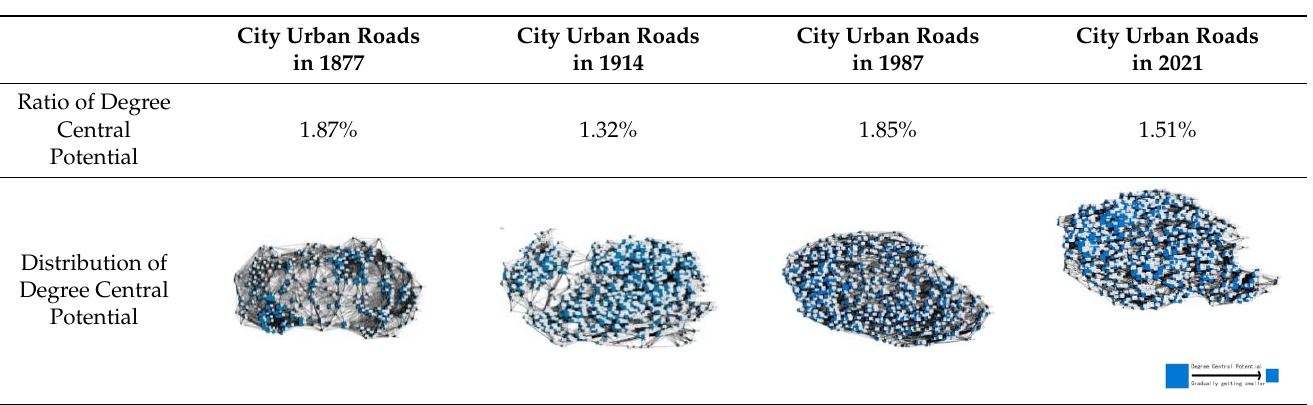
Table 5. Statistics on the Degree of Central Potential in the Changsha Historic Urban City in Various Periods.